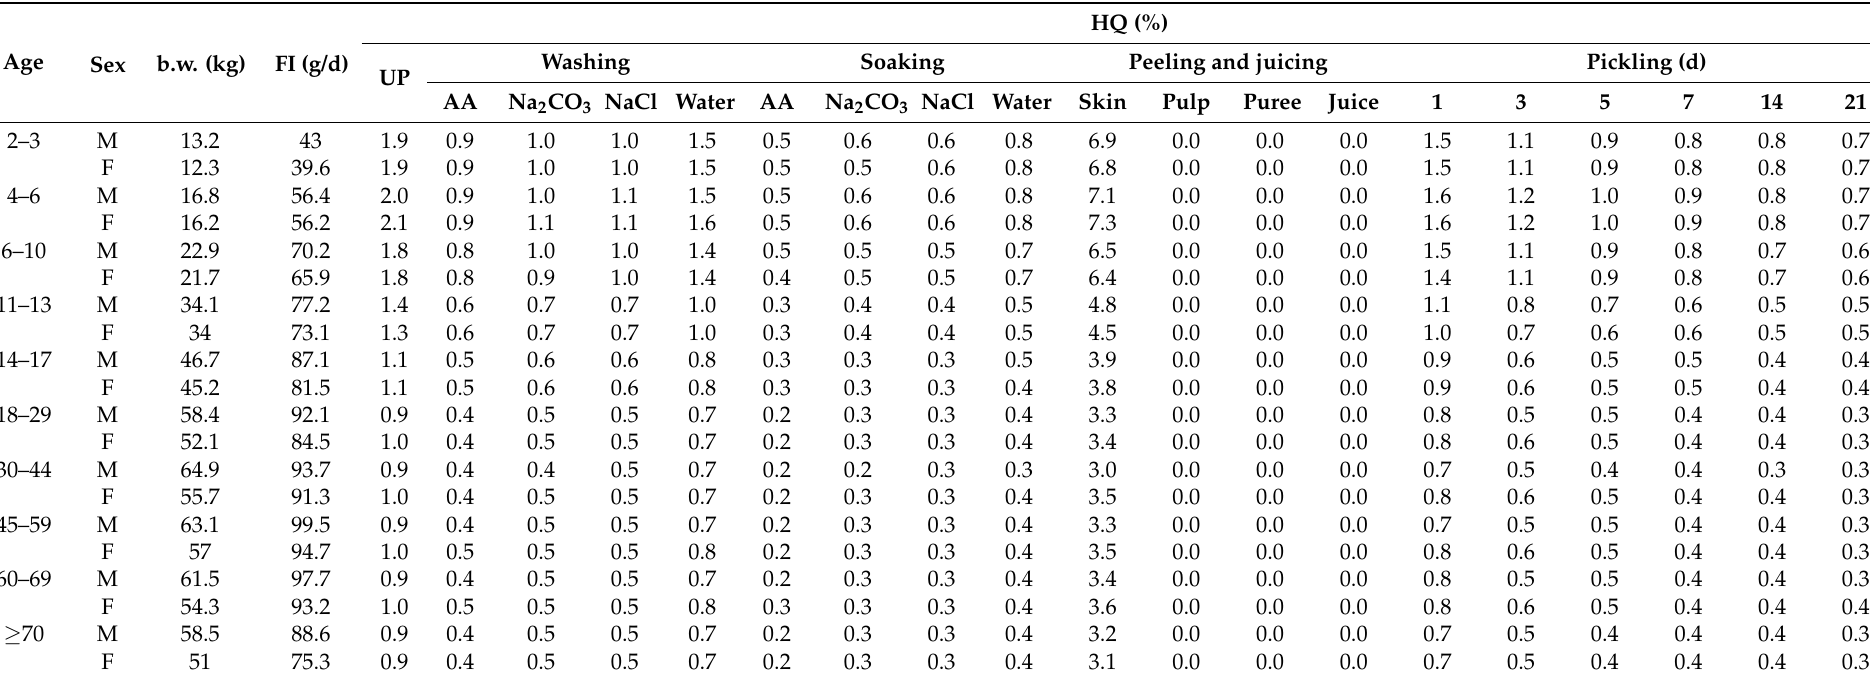
Table 7. Hazard quotient (HQ) of rac -mandipropamid in unprocessed (UP) and processing cucumber samples for different groups of Chinese